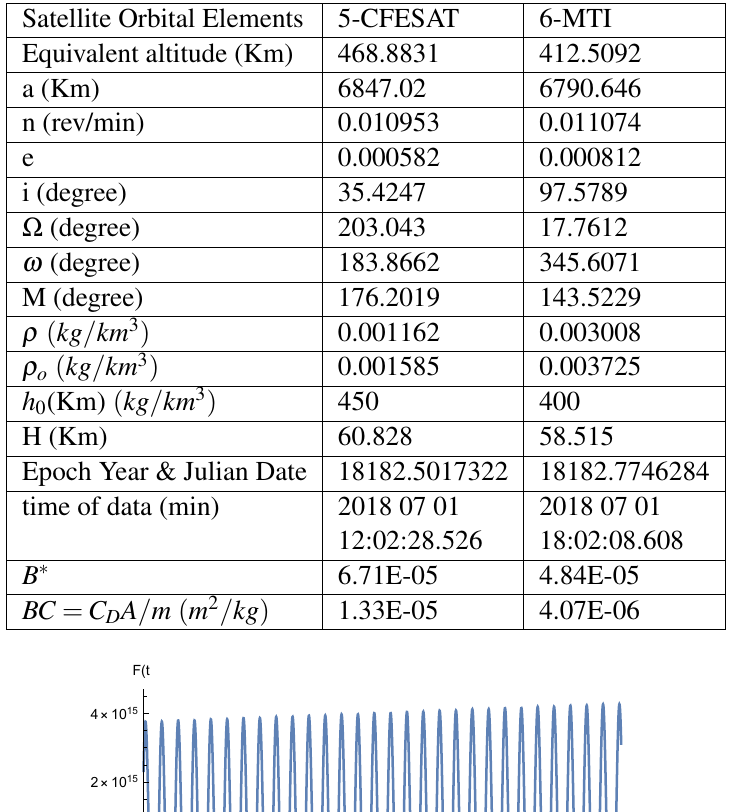
Table 2 Norad Two - Line Element Sets For The Satellites CFESAT and MTI